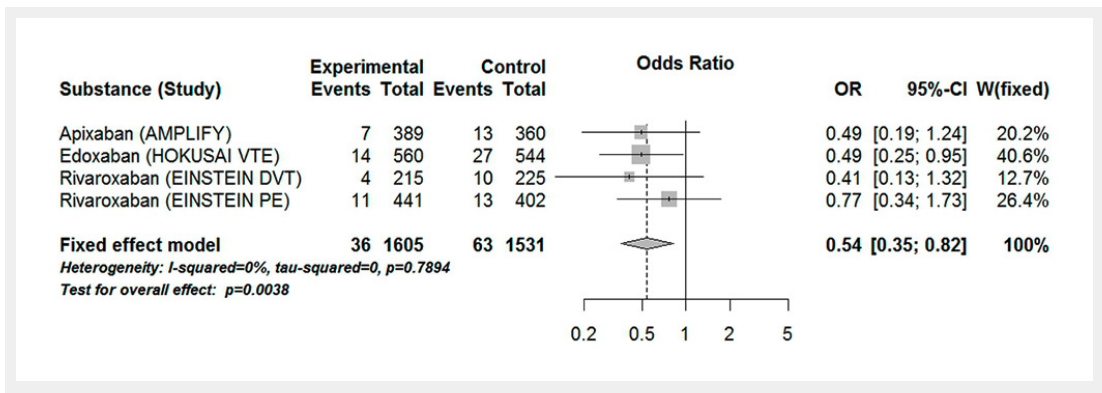
Figure 7 Forest plot of composite endpoint recurrent VTE or VTE-related death in patients with VTE aged 75 years or over. CI = confidence interval; experimental = direct oral anticoagulants; control = vitamin K antagonists; DVT = deep vein thromboembolism; PE = pulmonary embolism; VTE = venous thromboembolism